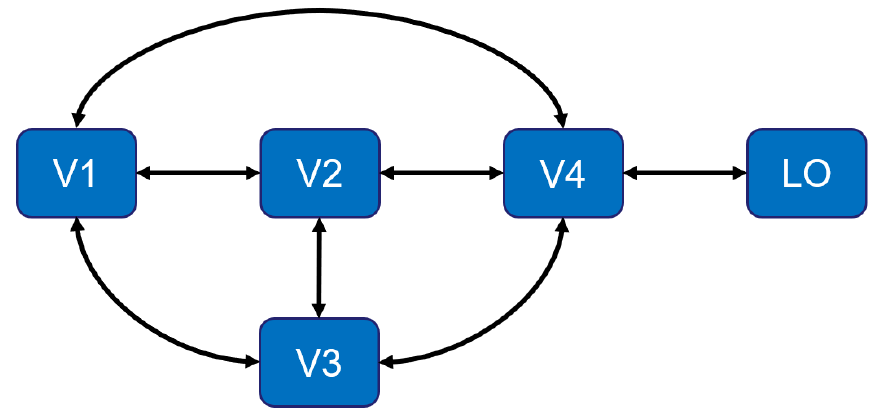
Figure 5. The diagram of connections between brain regions. Table 1 indicates that for the original VGG16 and ResNet50 models, the top 100 Pcc values of the two models for the seven brain regions are basically the same. For our mixed model, the top 100 correlation values for the seven brain regions are improved to varying degrees.